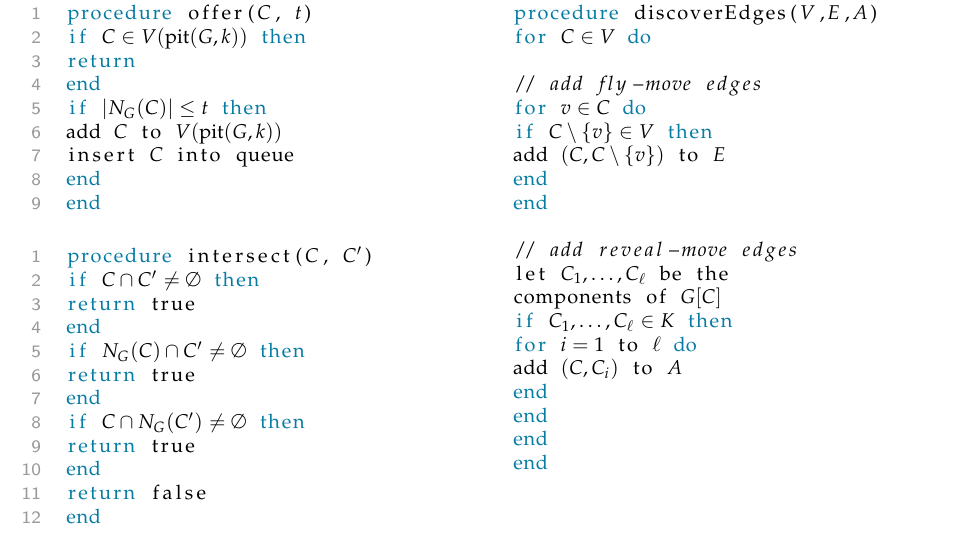
Figure 6. Subprocedures used by the discover algorithm. The offer procedure adds a block to the queue if t is not too large. The intersect procedure simply checks if two blocks are compatible (i. e., that they can be glued together), and the discoverEdges procedure identifies the edges of the